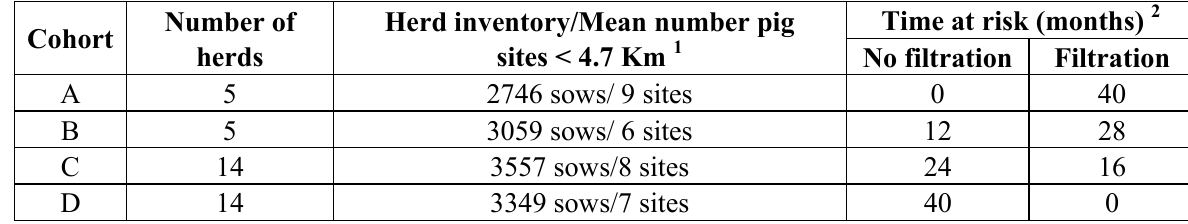
Table1. Description of farm cohorts included in the study.